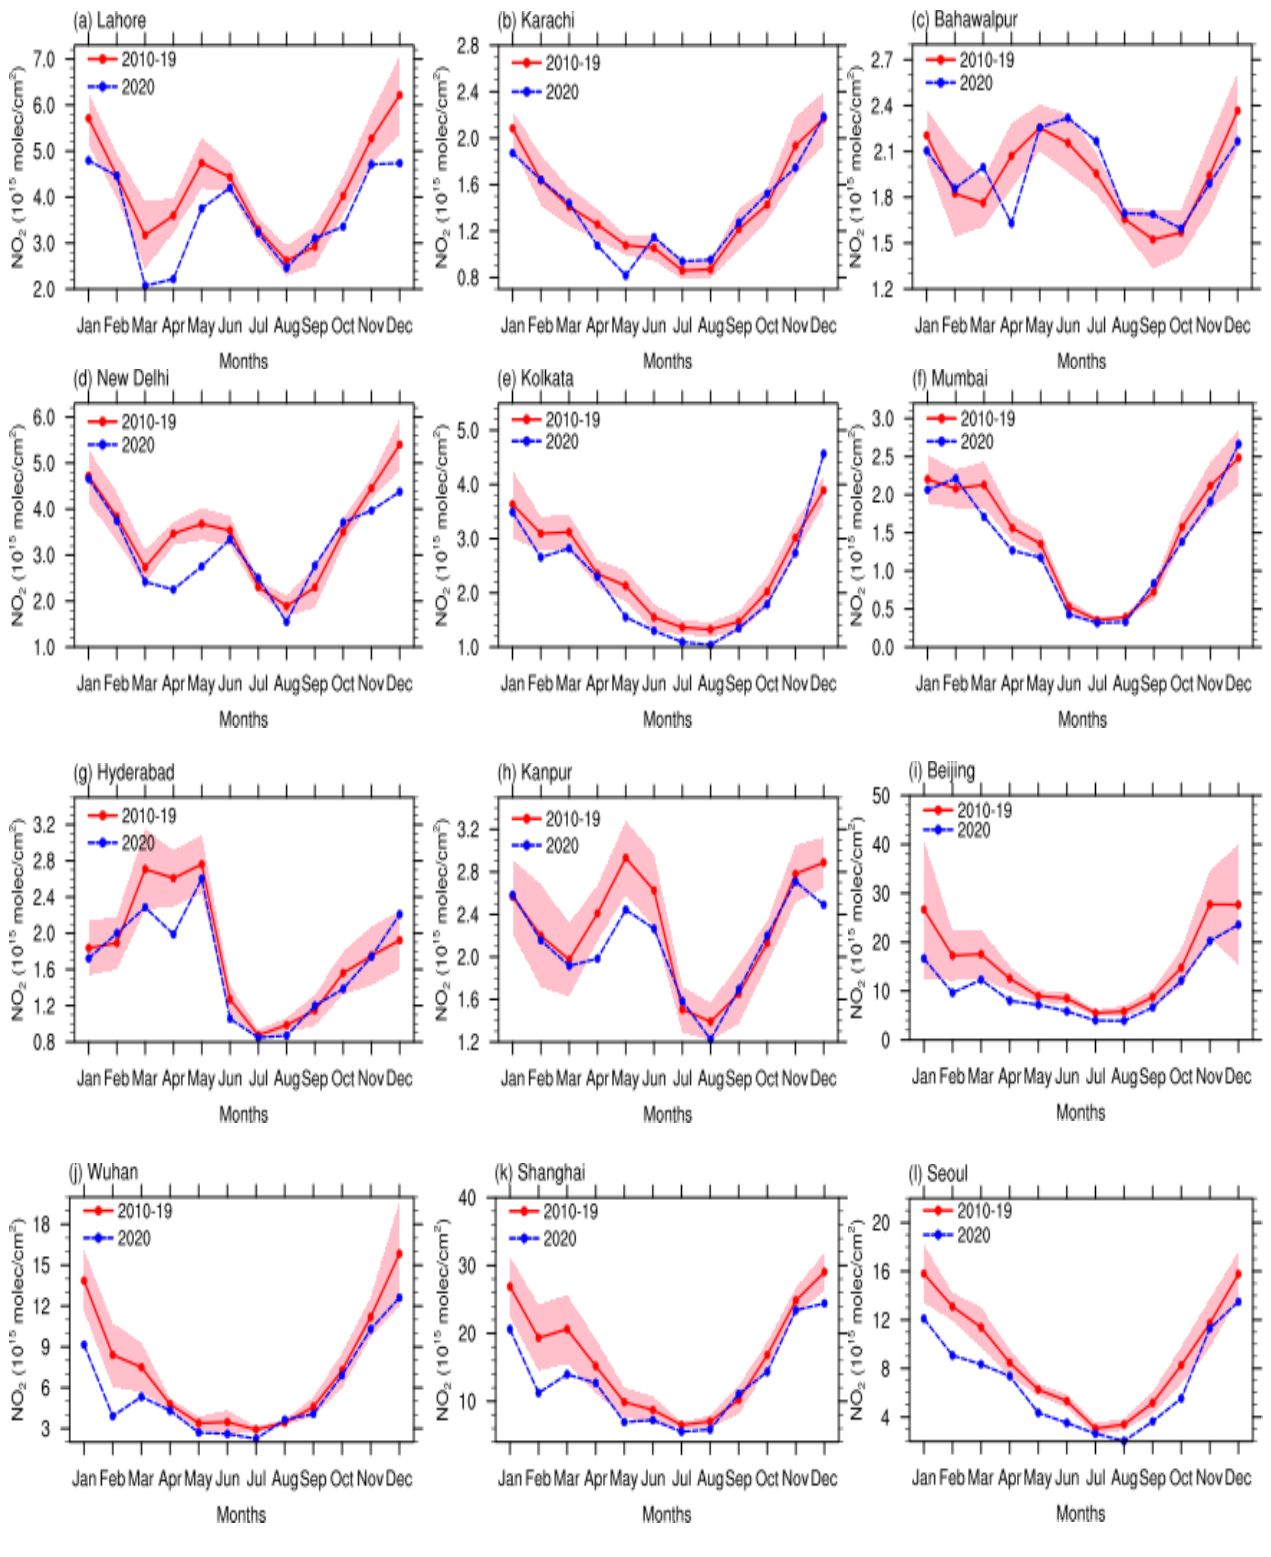
Figure 3. Changes in monthly NO 2 emissions in 2020 (during COVID-19), compared with the average of 2010–2019 (before COVID-19), with standard deviation (pink shading) in ( a ) Lahore, ( b ) Karachi, ( c ) Bahawalpur, ( d ) New Delhi, ( e ) Kolkata, ( f ) Mumbai, ( g ) Hyderabad, ( h ) Kanpur, ( i ) Bei- jing, ( j ) Wuhan, ( k ) Shanghai, and ( l ) Seoul.